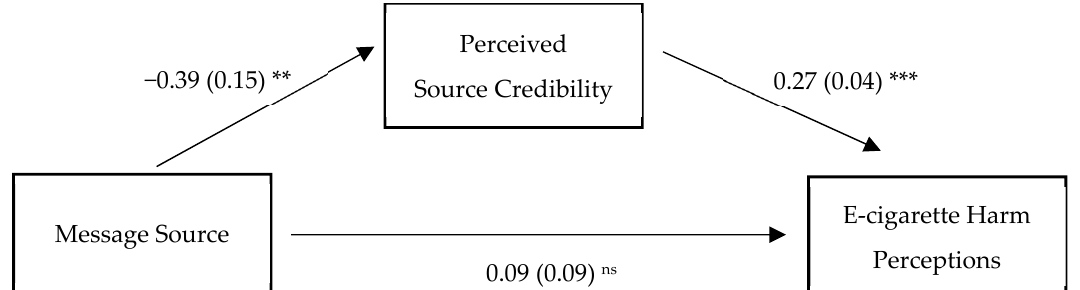
Figure 1. Indirect pathway from message source to e-cigarette harm perceptions mediated by perceived source credibility ( n = 302) 1 . *** p < 0.001, ** p < 0.01, ns: not statistically significant. 1 n = 302 young adults were randomized to view one of two message sources. Hayes PROCESS Macro was used to model mediated association between source type and outcome variables. The expert source condition was the reference group. The expert source (vs. peer) was associated with increased per- ceived source credibility. The source conditions were dummy coded into binary variables, with the expert group representing 0 and the peer group representing 1. Increased perceived source credi- bility was associated with increased e-cigarette harm perceptions. Unstandardized coefficient and standard error denote each path. Covariates included sociodemographic variables and e-cigarette use status.